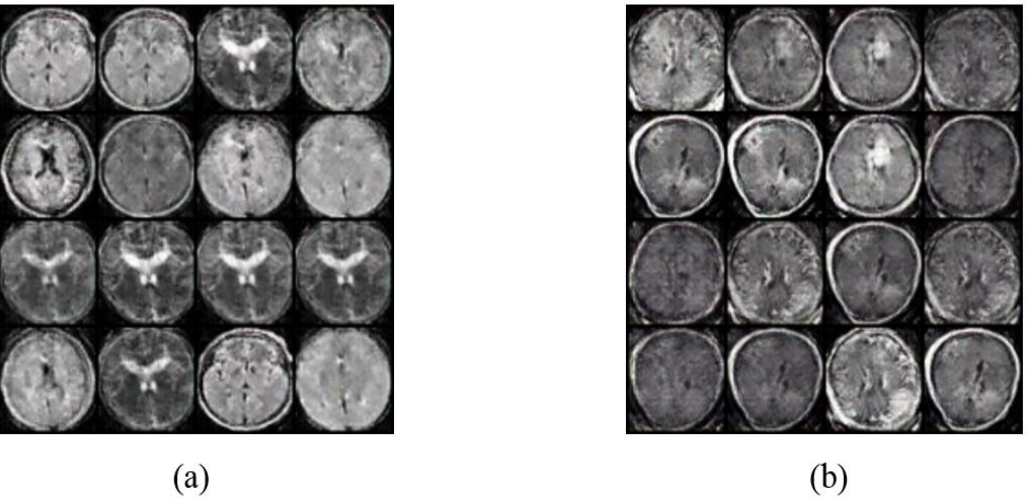
Figure 6. MRI scan images that are generated by applying Vanilla GANs for ( a ) Vanilla GANs no tumor images, and ( b ) Vanilla GANs tumor images.